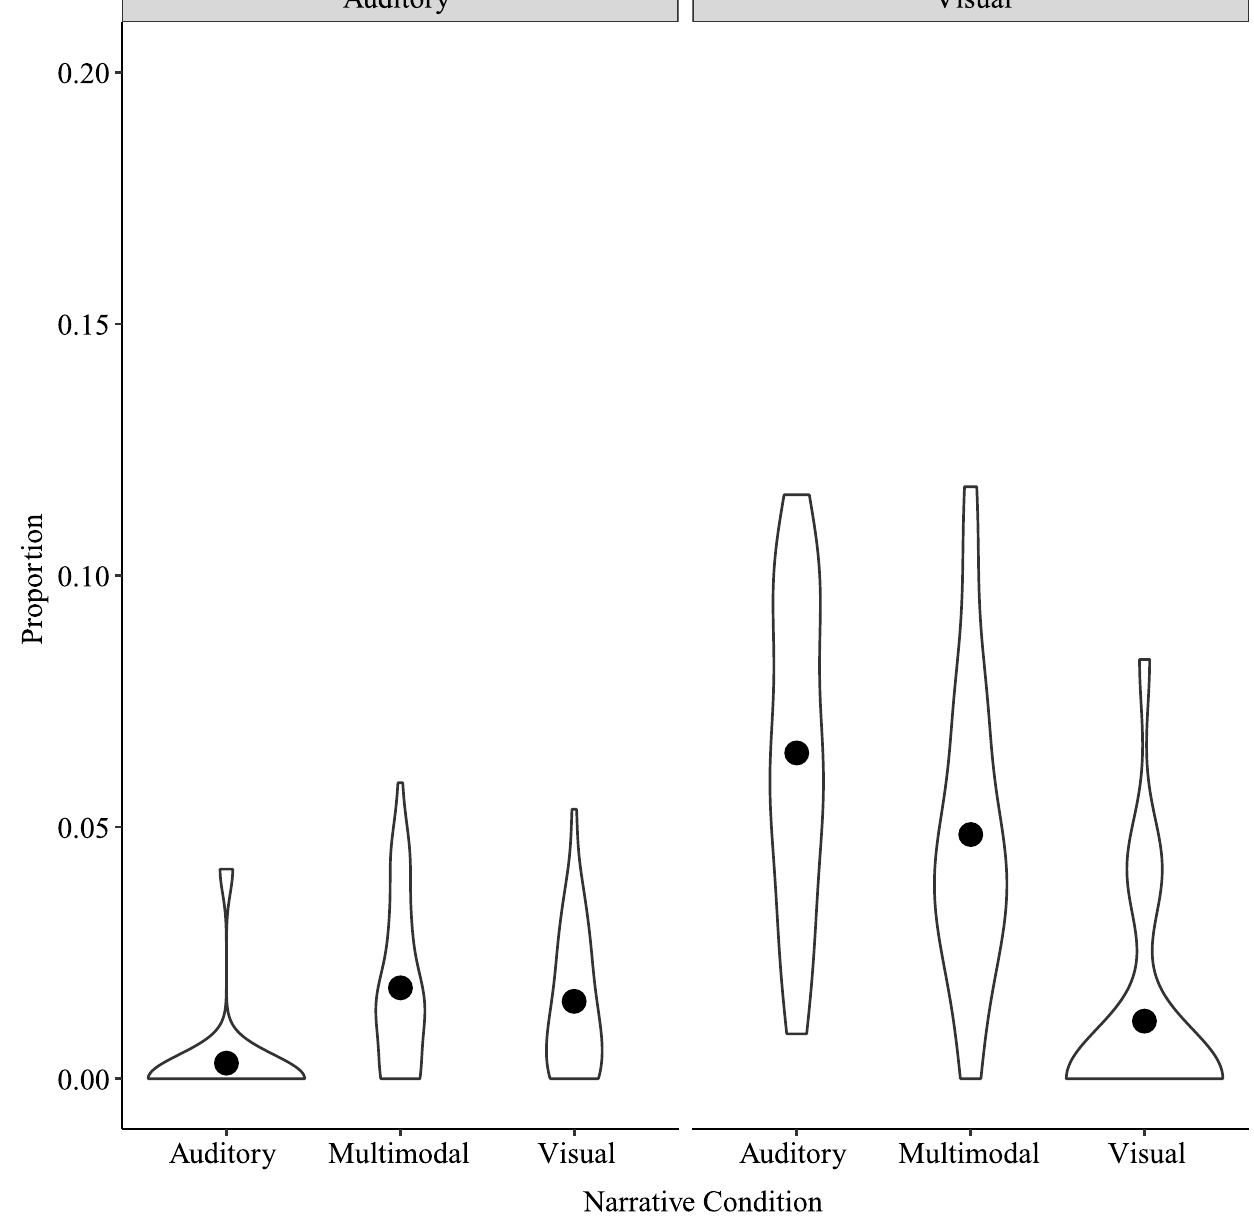
Fig 4. False recollections by Narrative Condition and Misremembered Detail Type for Study 1. Points show means for each Narrative Condition by Misremembered Detail Type. Note the y-axis scale, indicating very few false recollections.